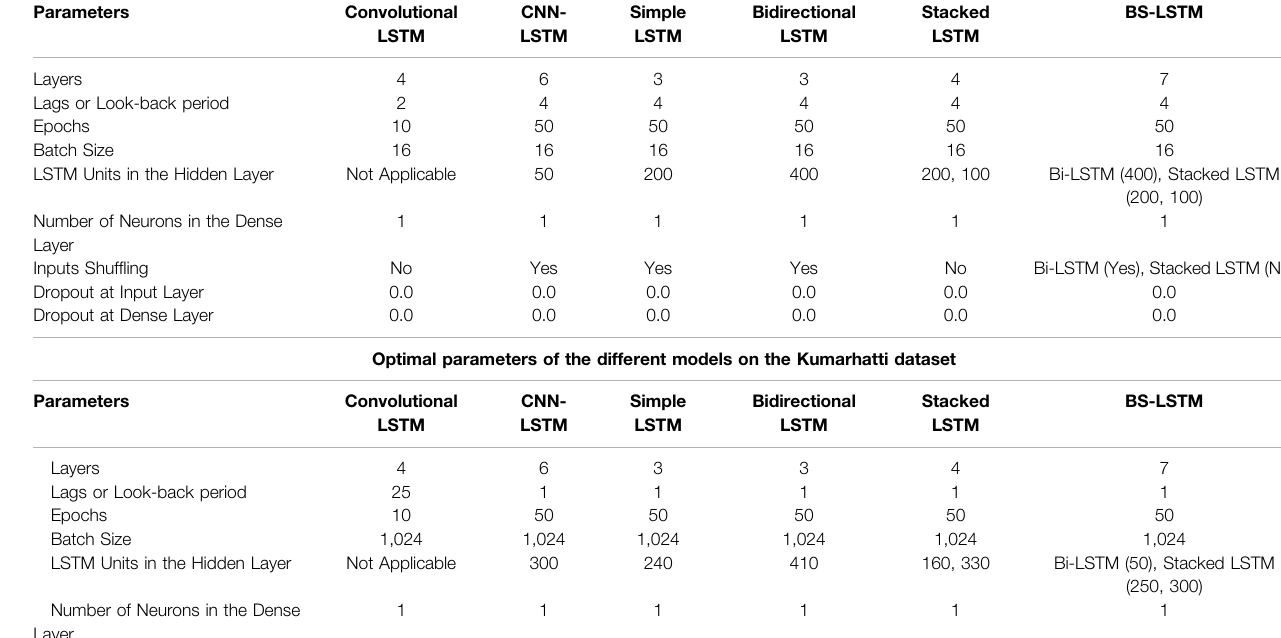
TABLE 4 | Optimized parameters for the different models on the Tangni and Kumarhatti datasets. Optimal parameters of the different models on the Tangni